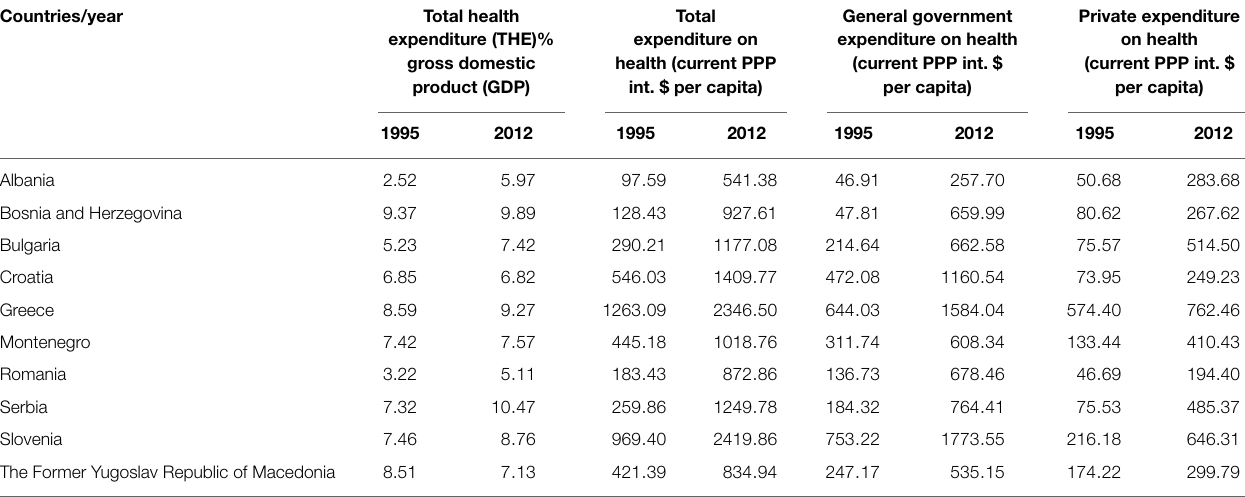
TABLE 1 | Expenditure data across selected Balkan countries – values reported to World Health Organization by the national authorities in 1995/2012* . Countries/year Total health expenditure (THE)% gross domestic product